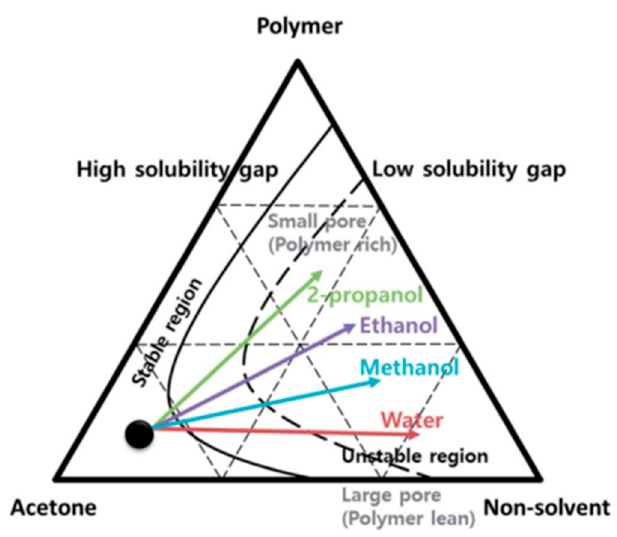
Figure 4. Phase diagram of the ternary mixture—PVDF–HFP, acetone, and non-solvent—in order to control PVDF-HFP membrane morphology [46], with copyright permission from the Royal Society of Chemistry.